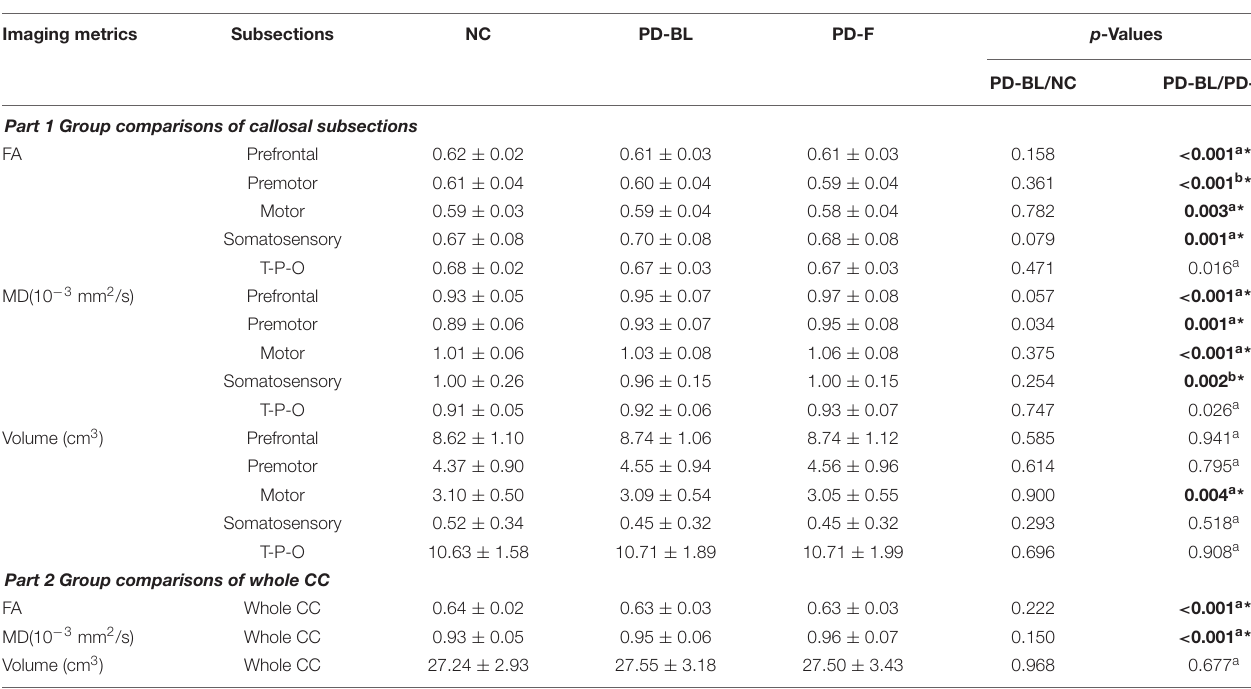
TABLE 3 | Group comparisons of callosal structural